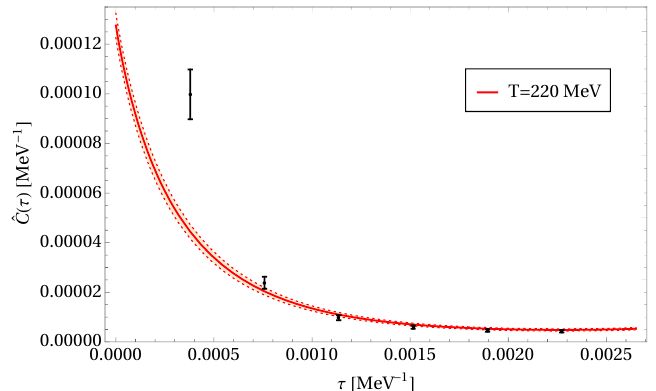
Figure 3 . The ˆ C PS ( τ ) prediction against the rescaled lattice data (black points) for T = 220 MeV. The error bars and coloured band indicate the estimated combined